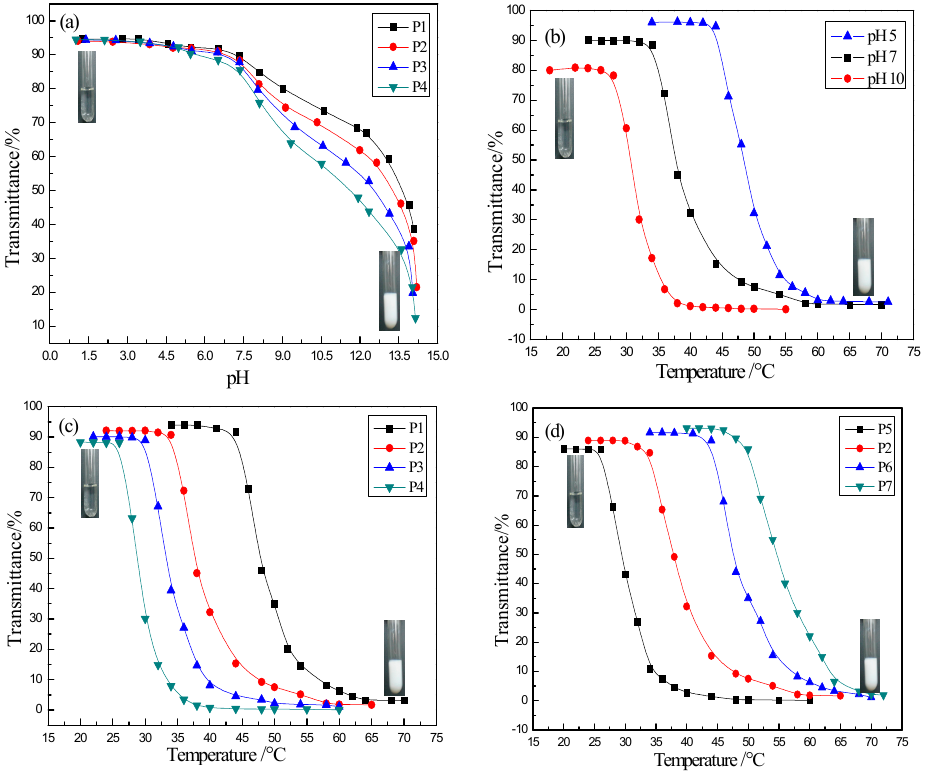
Figure 1. Transmittance curves of: ( a ) P1, P2, P3, P4 in aqueous solutions versus pH at 25 °C; ( b ) P2 in aqueous solution versus temperature at different pH; ( c ) P1, P2, P3, P4 in aqueous solutions versus temperature; and ( d ) P5, P2, P6, P7 in aqueous solutions versus temperature. (0.5 mg·mL − 1 ).